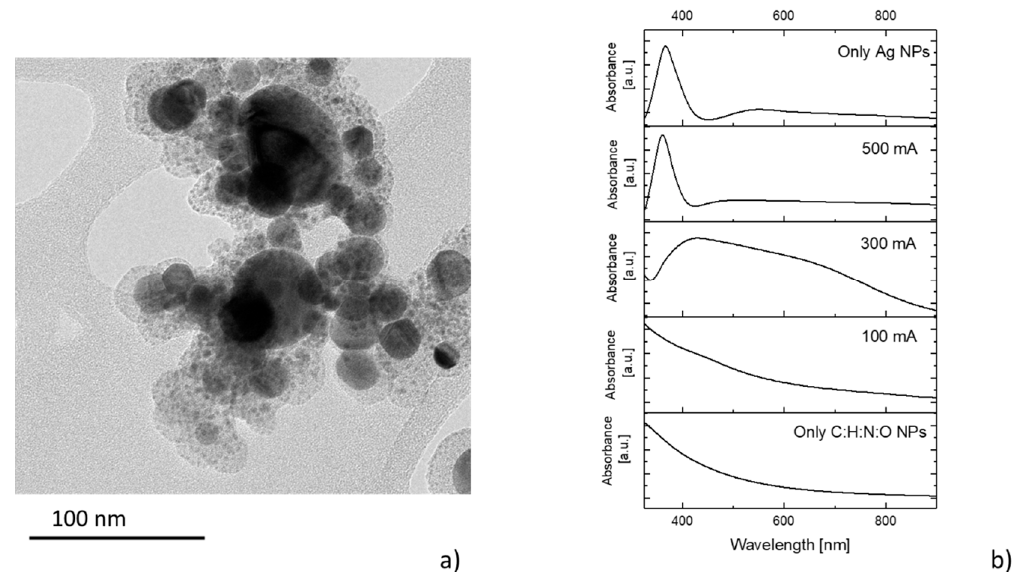
Figure 7. ( a ) TEM image of NPs produced when the dual-magnetron Gas Aggregation cluster Source (GAS) system was used. ( b ) UV-Vis spectra of produced NPs at different DC magnetron currents used for silver sputtering. RF power 40 W.